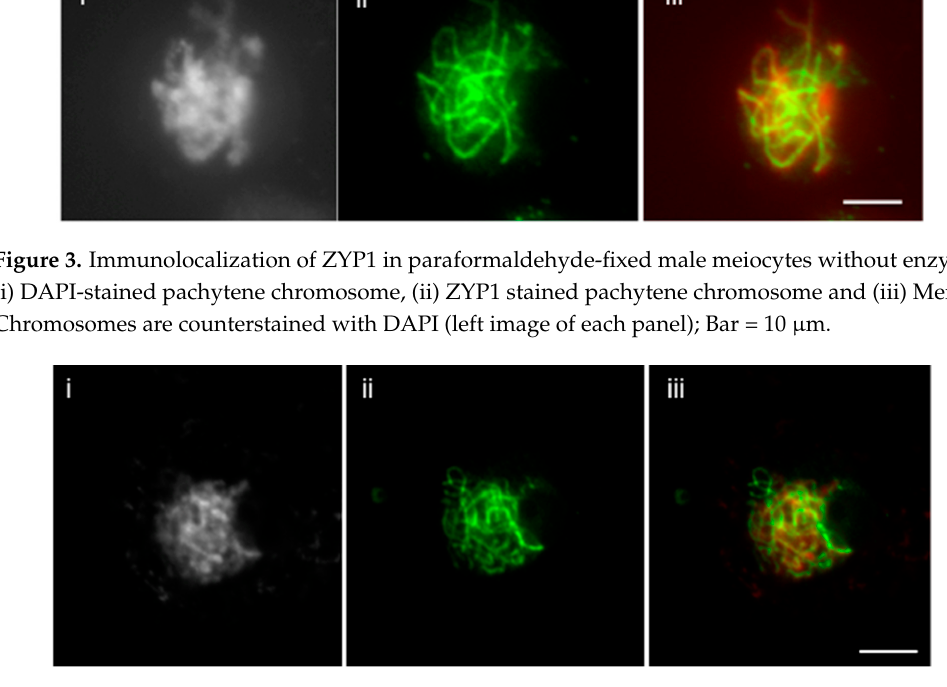
Figure 4. Immunolocalization of ASY1 in paraformaldehyde-fixed male meiocytes without enzymes. (i) DAPI-stained pachytene chromosome, (ii) ASY1 stained stained pachytene chromosome and (iii) Merged. Chromosomes are counterstained with DAPI (left image of each panel); Bar = 10 μ m.